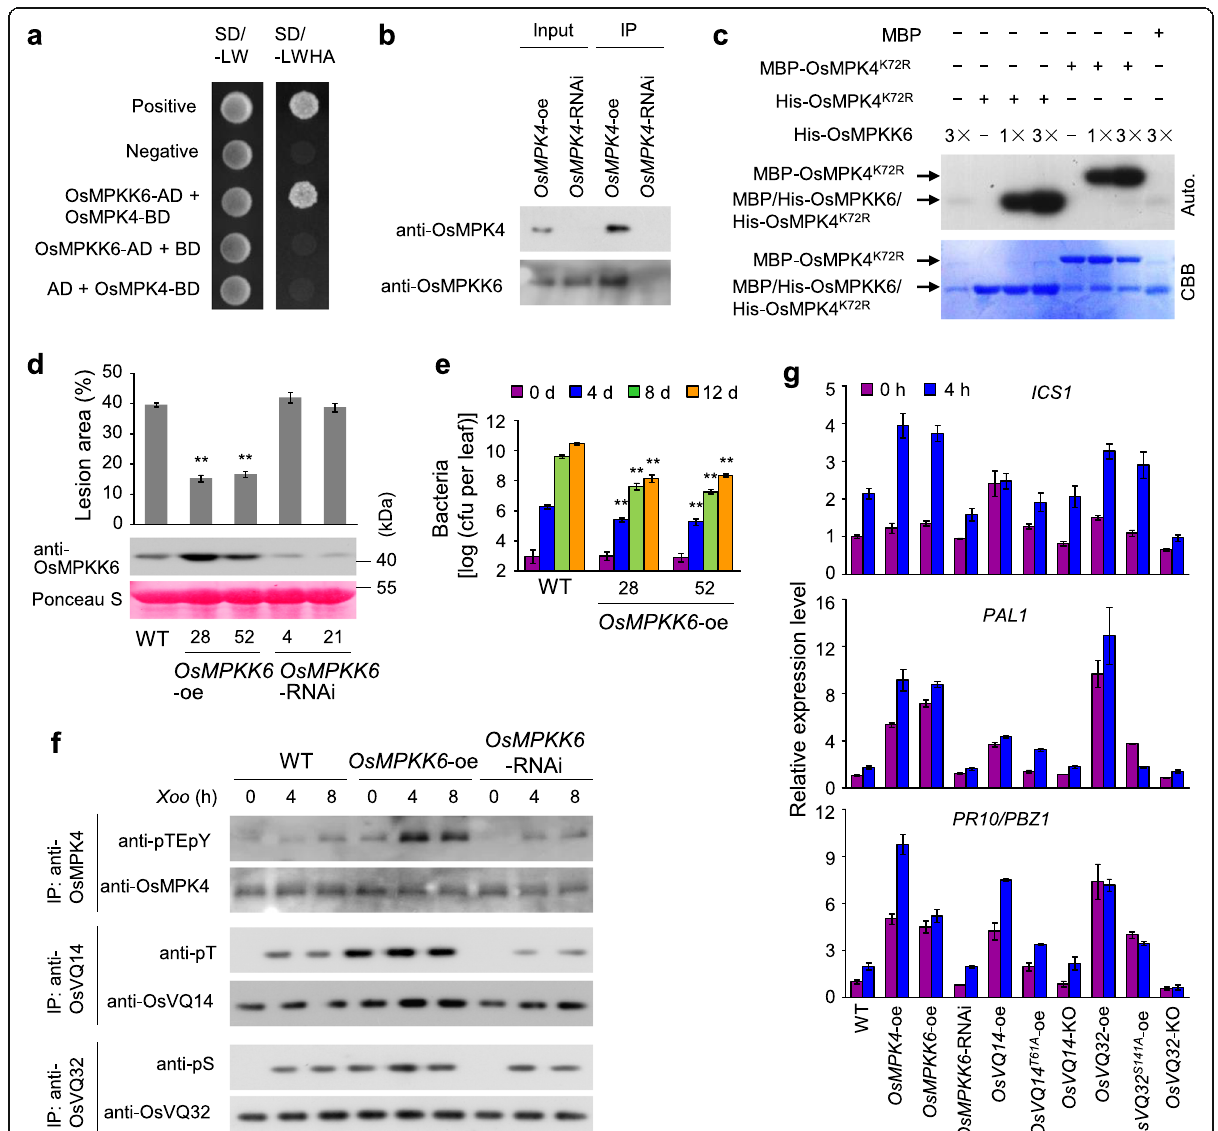
Fig. 6 OsMPKK6 promoted OsMPK4-OsVQ14/OsVQ32 cascade phosphorylation in the rice response to Xoo . The asterisks “ ** ” indicate a significant difference between transgenic plants and WT plants at P < 0.01. a Interaction of OsMPK4 with OsMPKK6 in yeast. The interactions were assessed by growing yeast cells on synthetic defined premixes (SD) medium lacking ( − ) leucine (L), tryptophan (W), histidine (H), and adenine (A). AD, activation domain; BD, DNA-binding domain. Co-transformation of BD-53 and AD-RecT was used as the positive control while co-transformation of BD-Lam and AD-RecT was used as the negative control. b Interaction of OsMPK4 with OsMPKK6 in rice plants was analyzed by co- immunoprecipitation assay. Total protein was extracted from rice leaves and anti-OsMPK4 antibody was used for the immunoprecipitation (IP). c Phosphorylation assays of OsMPK4 K72R by OsMPKK6 in vitro. Auto., Autoradiograph; CBB, Coomassie brilliant blue staining. d Analysis of the response of OsMPKK6 transgenic plants to Xoo infection. Bars represent mean (5 plants, with each plant having 3 to 5 leaves for lesion area) ± SD. e Analysis of the Xoo growth in rice leaves. Bars represent mean (3 leaves from 3 positive plants) ± SD. The significant difference was detected between transgenic plants and WT with the same treatment. cfu, colony-forming unit. f Analyses of the phosphorylation of OsMPK4, OsVQ14 and OsVQ32 in rice plants before and after Xoo infection. 0 h, immediately before Xoo inoculation. IP, immunoprecipitated. g Analyses of the expression of salicylic acid (SA)-signaling genes before (0 h) and after (4 h) Xoo infection. Bars represent the mean (three replicates) ±